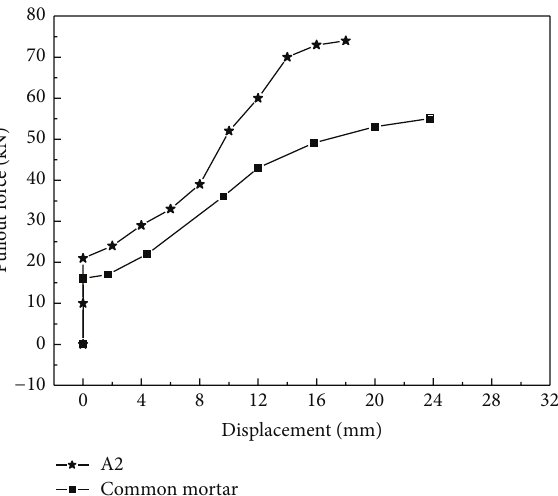
Figure 9: Load-displacement curves of pullout tests.